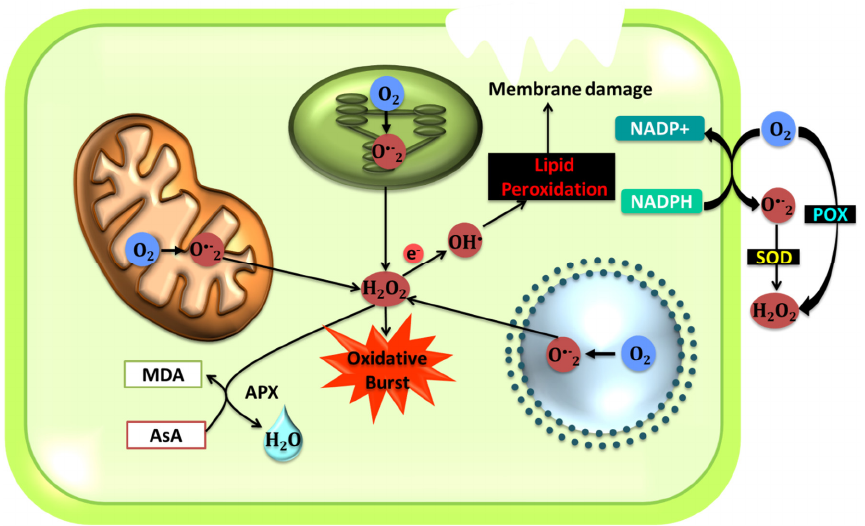
Figure 4. The processes involved in the production and control of ROS in different organelles within a plant system. The above is observed during stress response in plants. All these organelles are collectively responsible at maintaining ROS homeostasis in the cell.